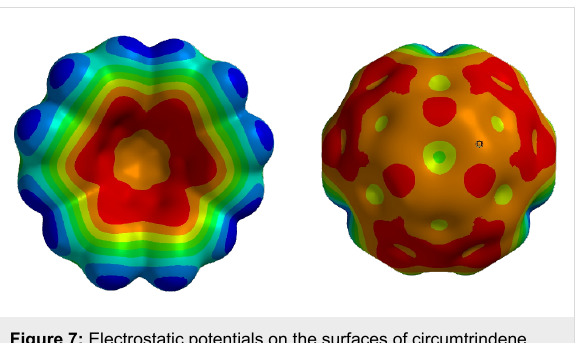
Figure 7: Electrostatic potentials on the surfaces of circumtrindene